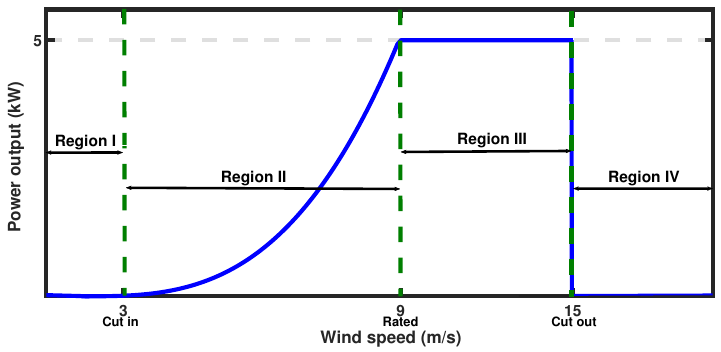
Figure 2. Different operating region of the PMVG-based WECS.